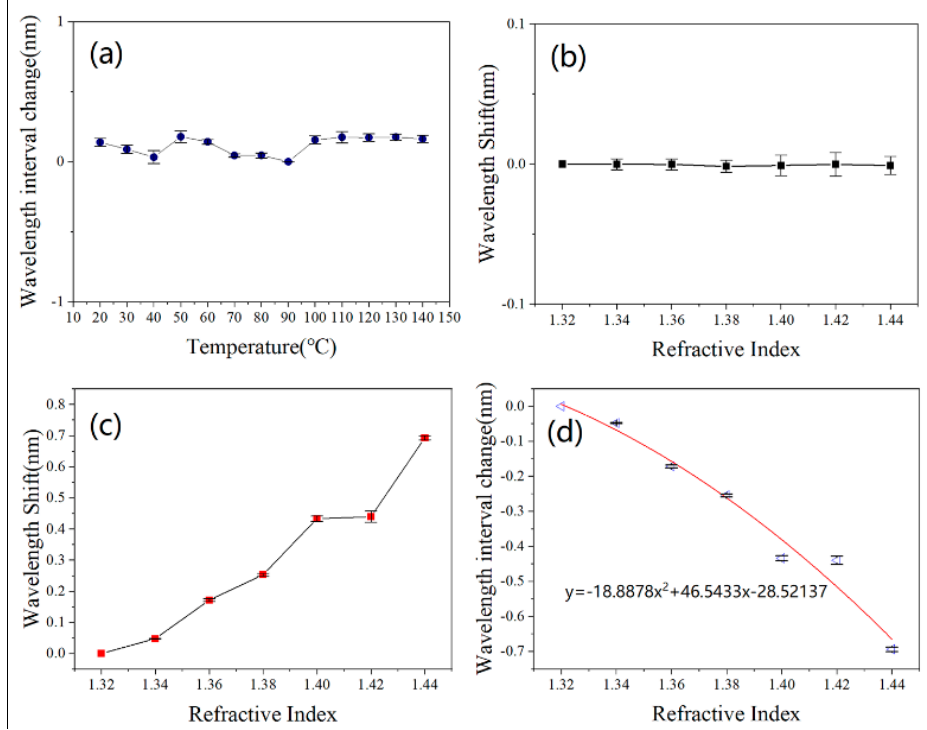
Figure 3. ( a ) Wavelength interval change with different temperatures; ( b ) value change of λ a ; ( c ) value change of λ b ; ( d ) wavelength interval change with different LRIs.